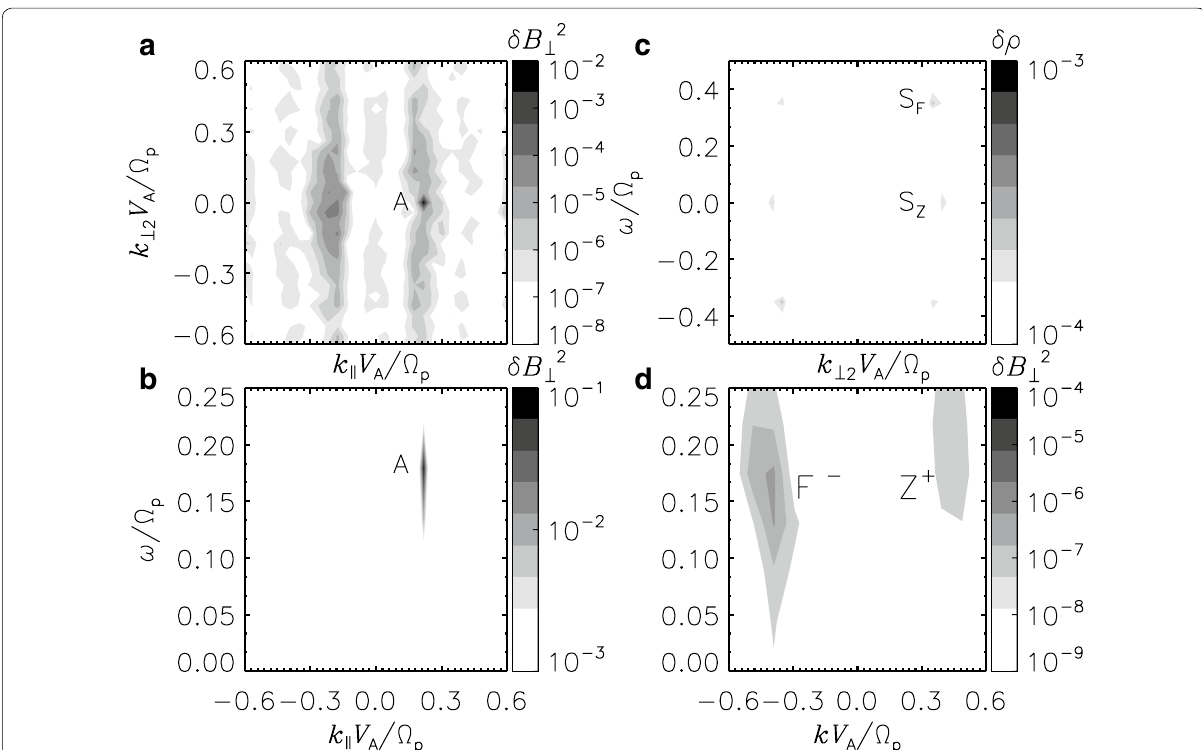
Fig. 2 Wavevector diagram for the magnetic field fluctuations ( a ), and dispersion diagrams for the pump Alfvén wave ( b ), density perturbation ( c ), and daughter Alfvén waves ( d )